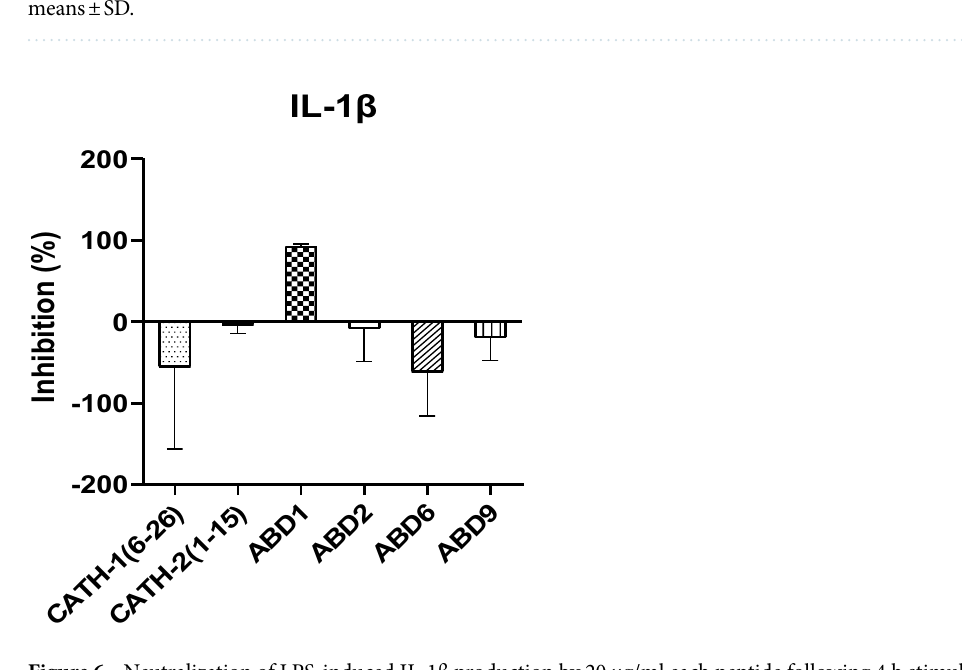
Figure 6. Neutralization of LPS-induced IL-1β production by 20 µg/ml each peptide following 4 h stimulation. Data from two separate experiments with three replicates in each experiment, means ±